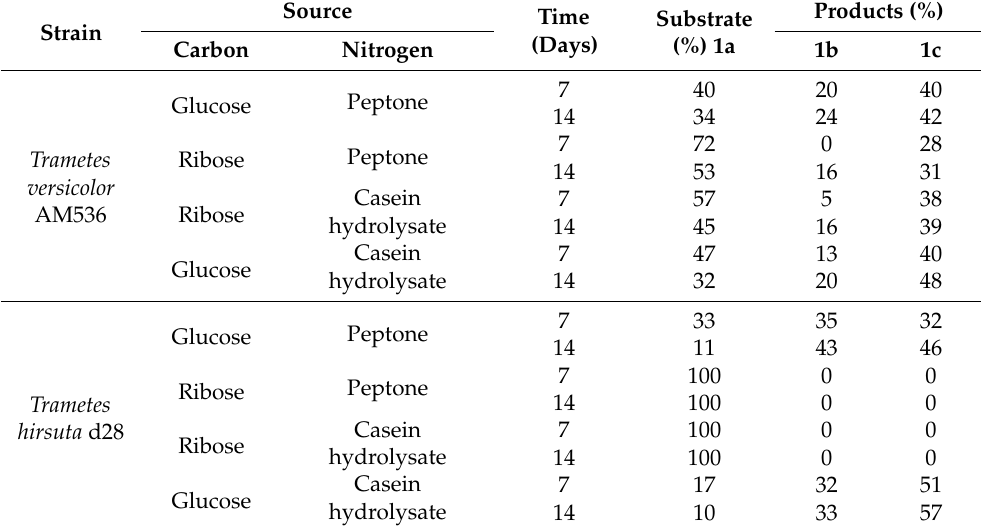
Table 3. Biotransformation of isosafrole ( 1a ) by Trametes strains in selected carbon and nitrogen sources (percentage values according to the GC as the mean value of two replicates).